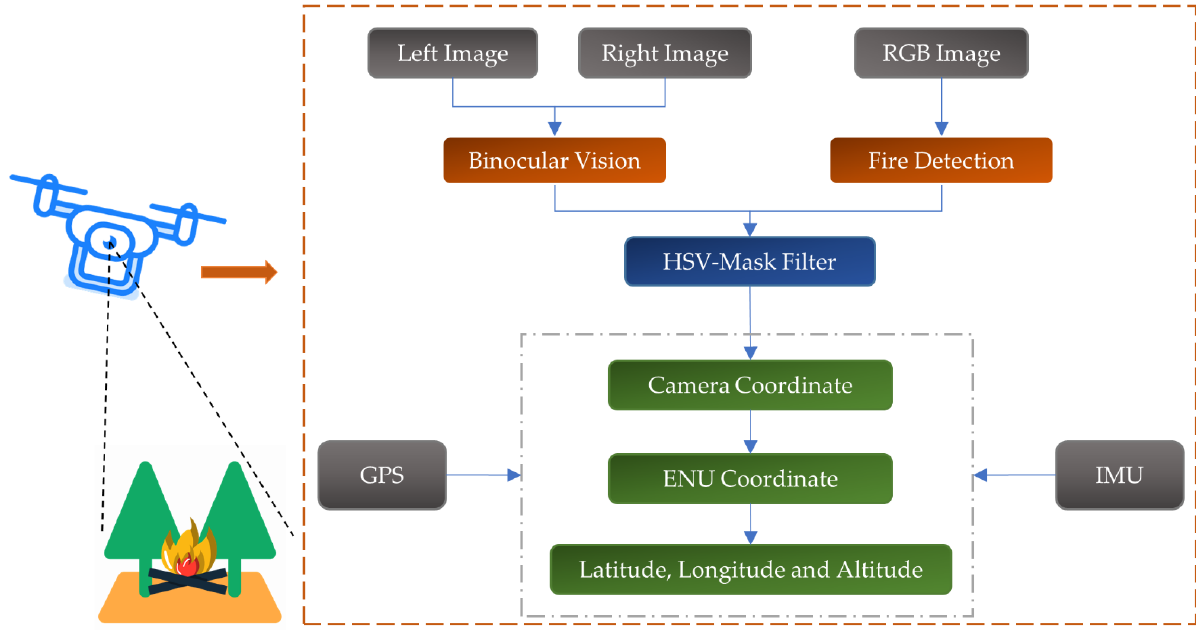
Figure 4. The sketch map of our scheme, containing binocular vision, fire detection, and location.